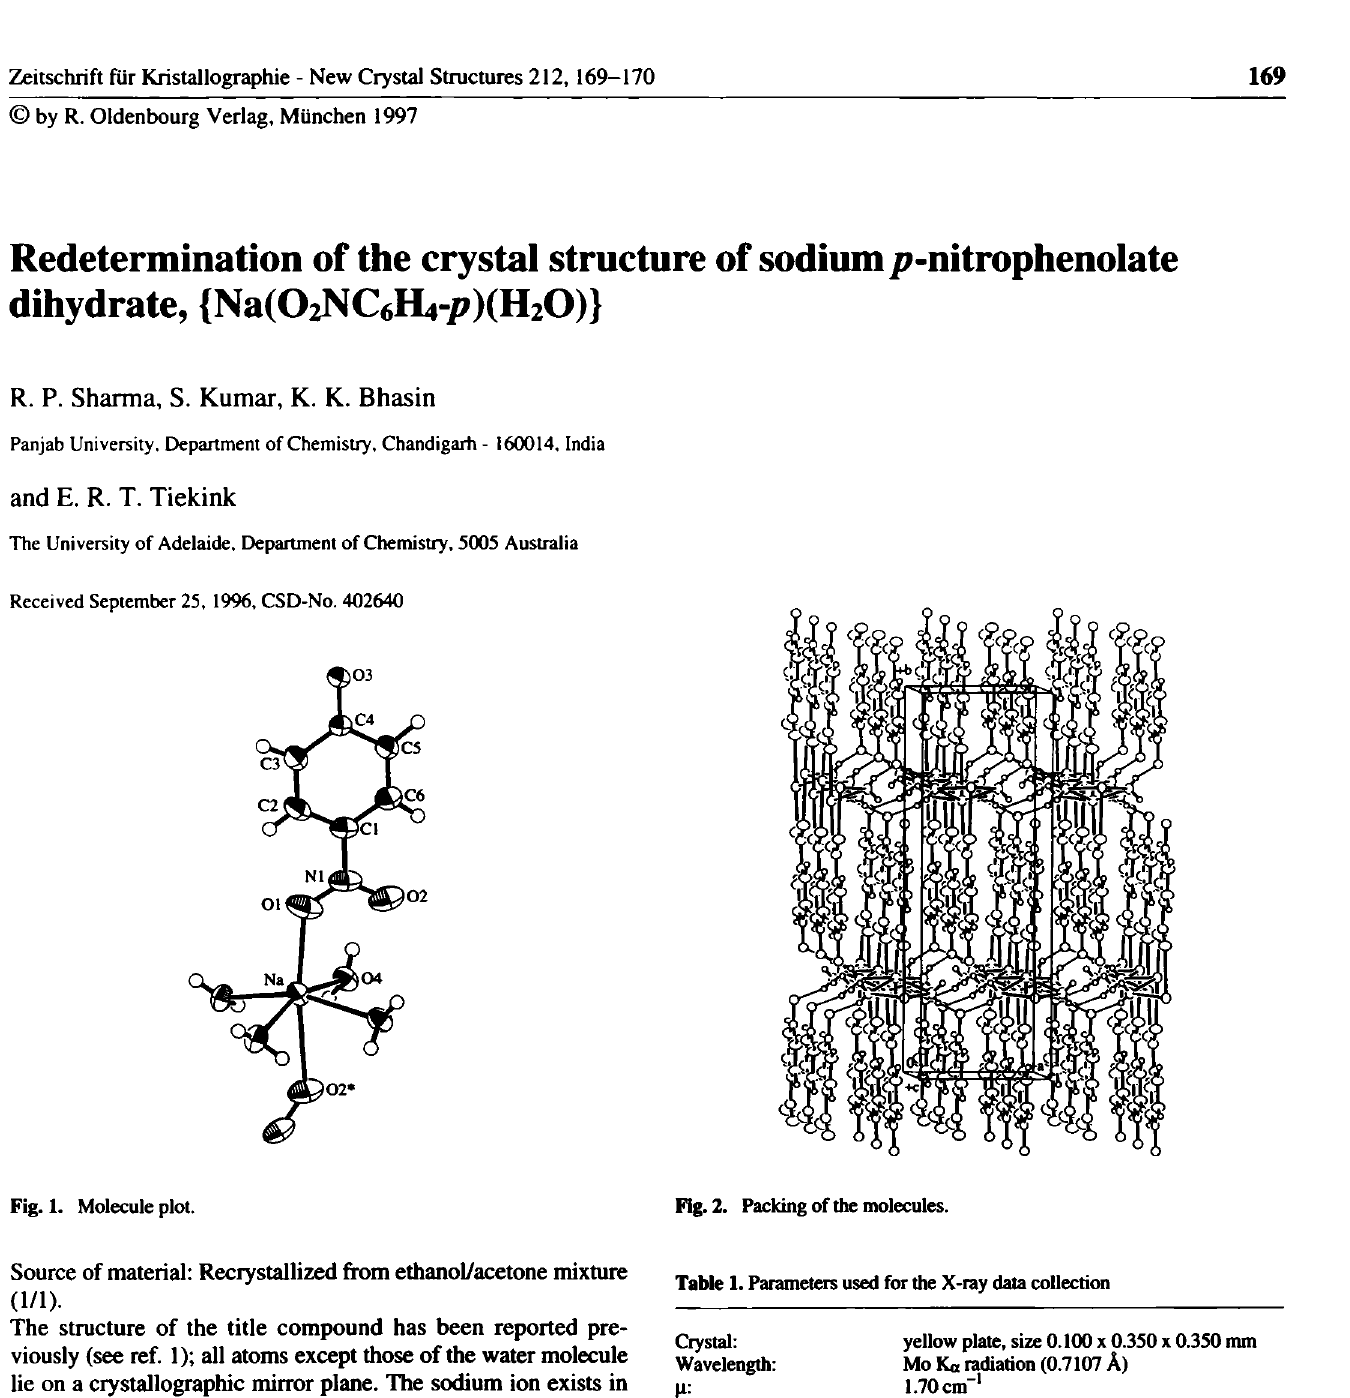
Fig. 1. Molecule plot. Fig. 2. Packing of the molecules.